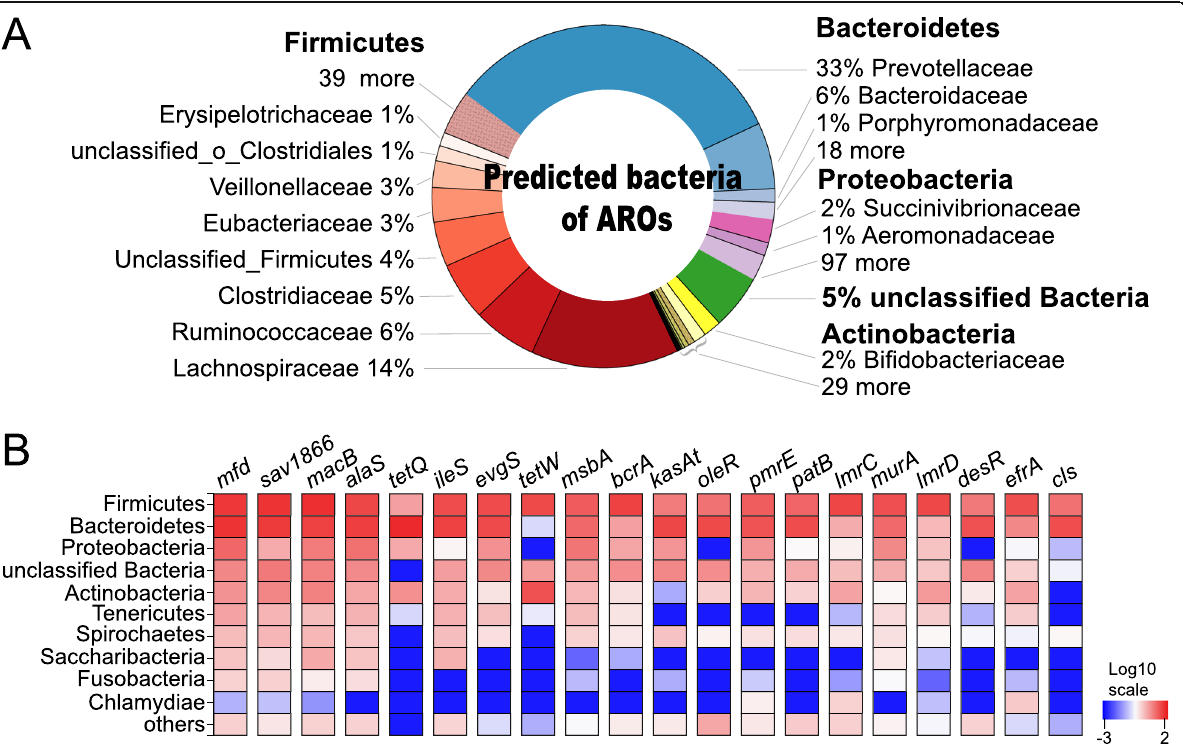
Fig. 3 The predicted bacterial taxa of the ruminal resistome and the relative abundances of related resistance genes. a Composition of observed bacterial taxa predicted by the ruminal resistome summarized at the phylum and family levels. b Distributions of ARGs in the phyla of predicted rumen bacteria. The top 10 phyla are displayed, with the remaining bacterial phyla included in the “ others ” category. The distributions of the ARGs are presented as coloured boxes, with the top 20 resistance genes listed. ARGs: antimicrobial resistance